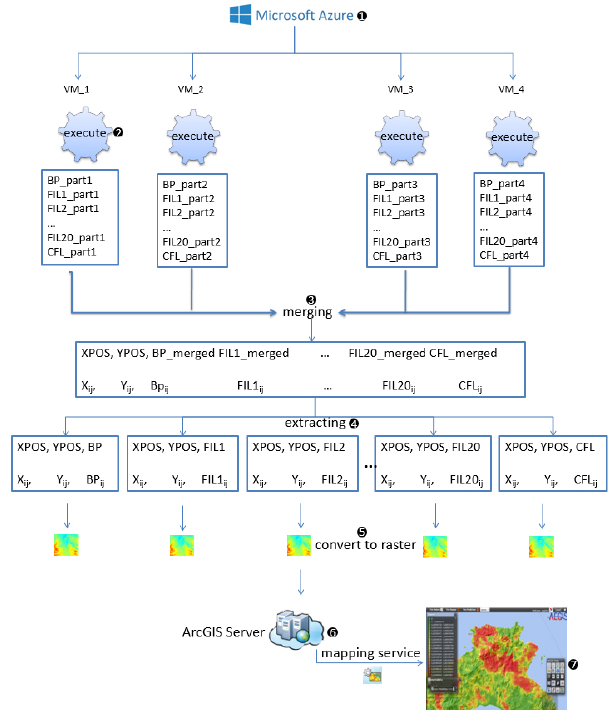
Figure 5. Information flow for the estimation of burn probability maps in